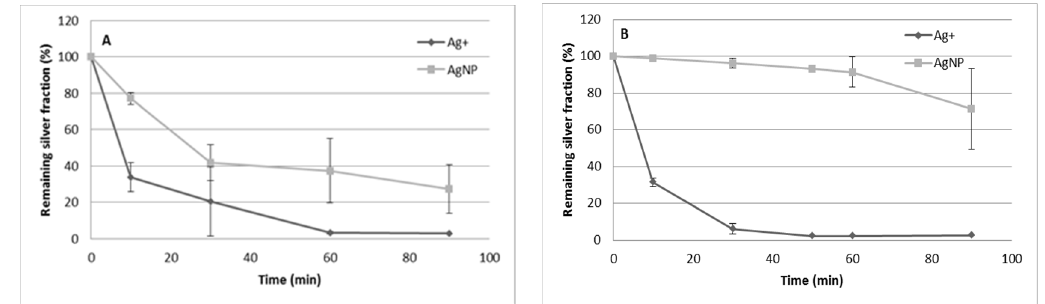
Figure 2. Remaining silver fraction vs. contact time. ( A ) Resin in acid form. ( B ) Resin in sodium form. Error bars represent standard deviation n = 2. Initial silver concentration is 57 μg·kg −1 for Ag + , and 85 μg·kg −1 for AgNPs.